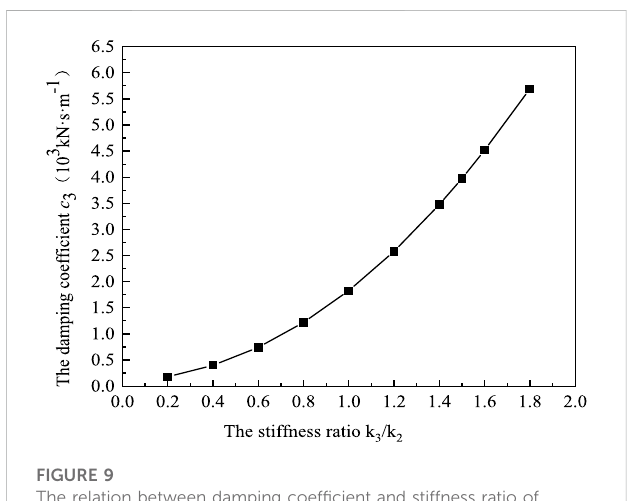
FIGURE 9 The relation between damping coef fi cient and stiffness ratio of vibration isolation